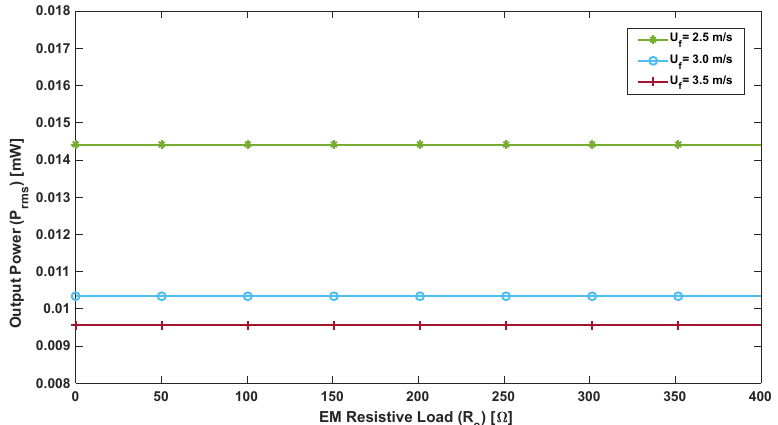
Figure 15. Power vs. piezoelectric harvester external load ( R p ) of the hybrid harvester at different wind speeds.